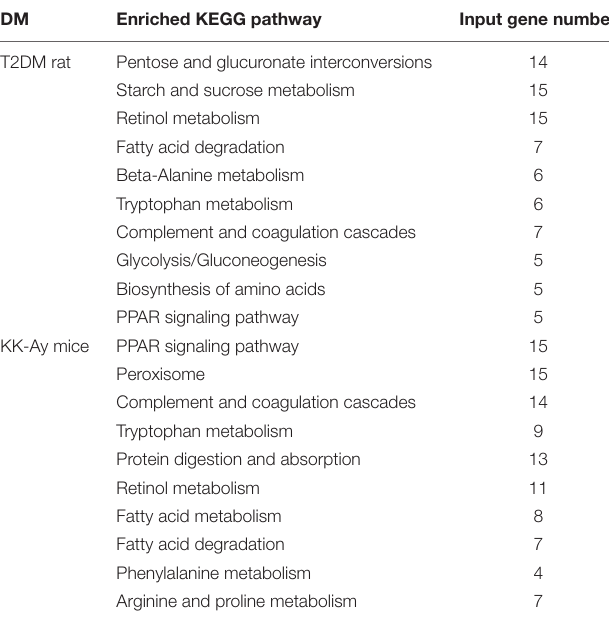
TABLE 4 | Enriched pathways from microarray detection of renal tissues in diabetic nephropathy. DM Enriched KEGG pathway Input gene